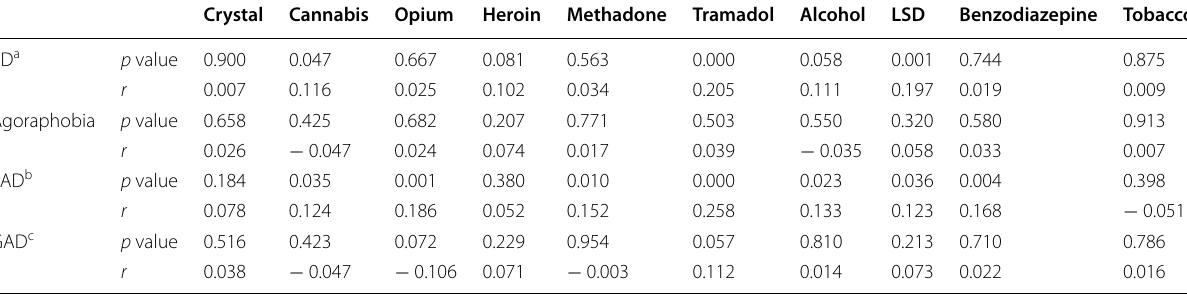
a Panic disorder b Social anxiety disorder